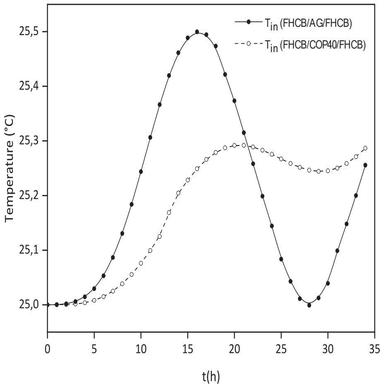
The average temperature on the interior faces of the wall along the day for different cases: HFCB/AG/HFCB - HFCB/COP40/HFCB.